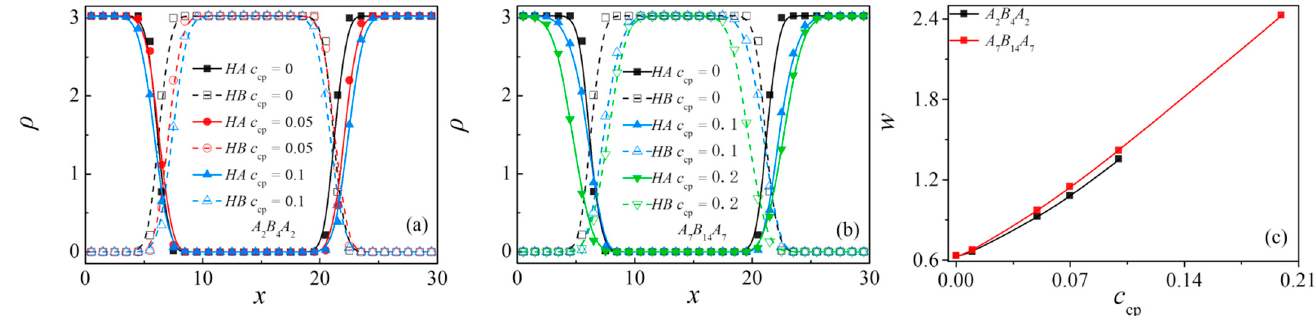
Figure 8. Density profiles of homopolymer beads along the x -axis as a function of triblock copolymer concentration at the copolymer chain length of ( a ) N cp = 8 and ( b ) N cp = 28, respectively. Interface thickness in ternary blends as a function of triblock copolymer concentration at the chain length of N cp = 8, 28 ( c ).